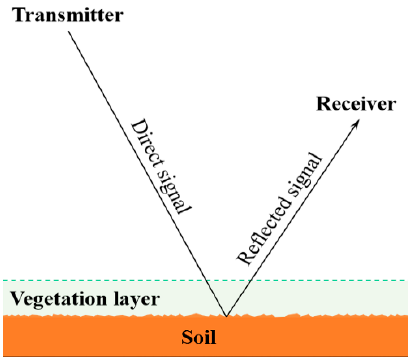
Figure 3. Bistatic radar geometry of spaceborne GNSS-R remote sensing soil detection.